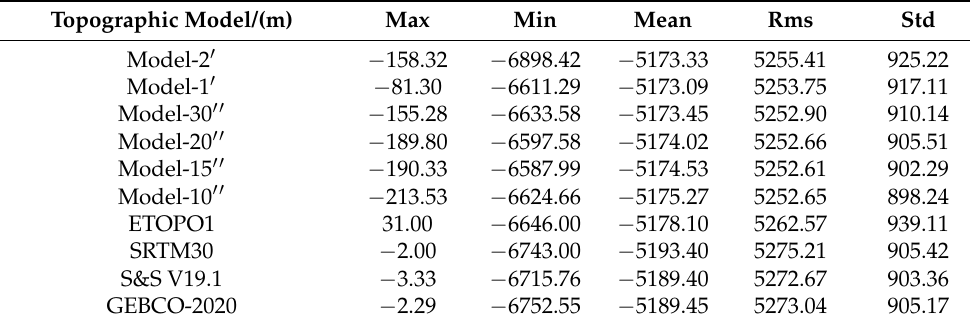
Figure 5. Topographic models with different resolution grid inversions (m). Table 2. Statistical analysis of various resolution seafloor topographic models (m).